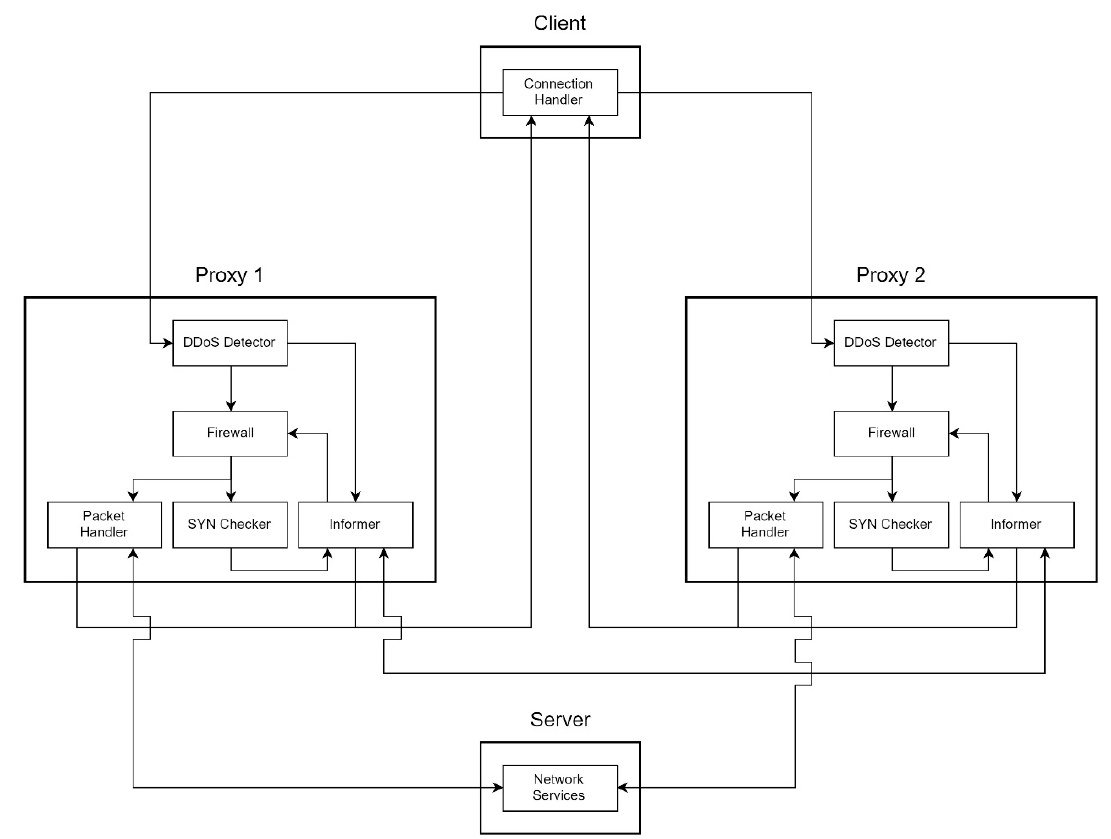
Figure 5. System overview.